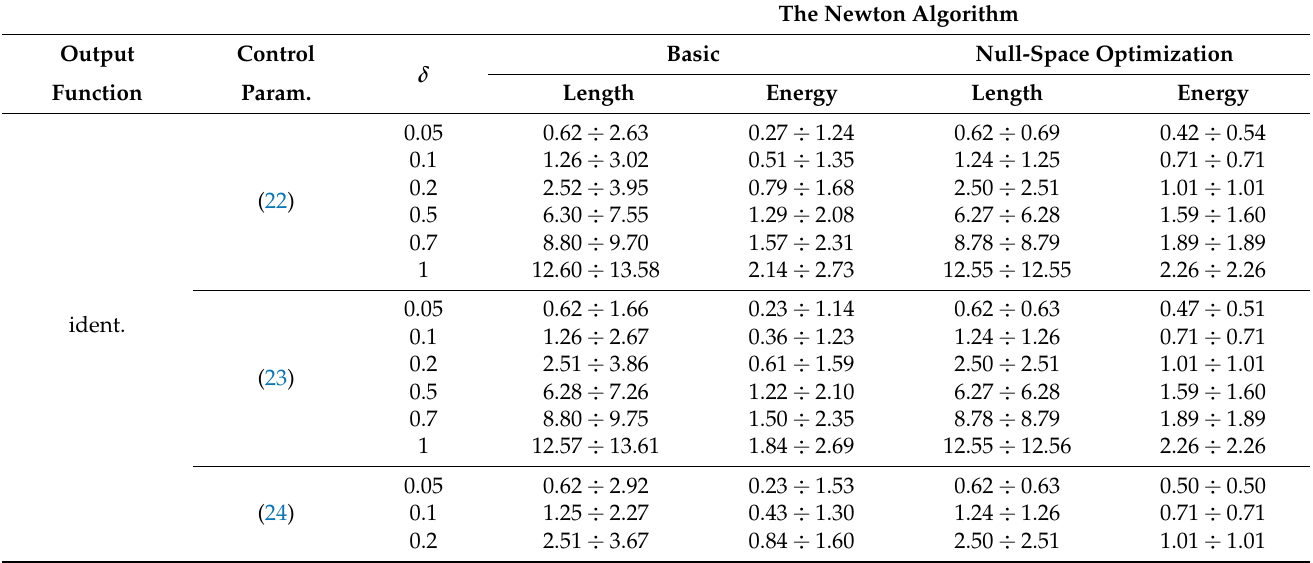
Table 4. Path length and energy of motion of the